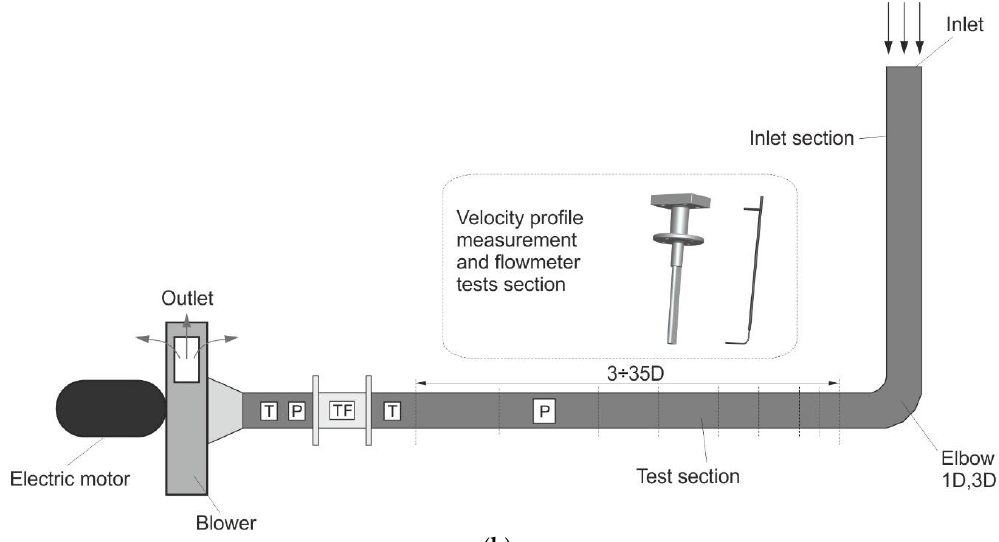
Figure 3. Experimental test stands. ( a ) general view with exemplary elbow obstacles, ( b ) schematic view: P—absolute pressure measurement, T—temperature measurement, TF—turbine flowmeter.